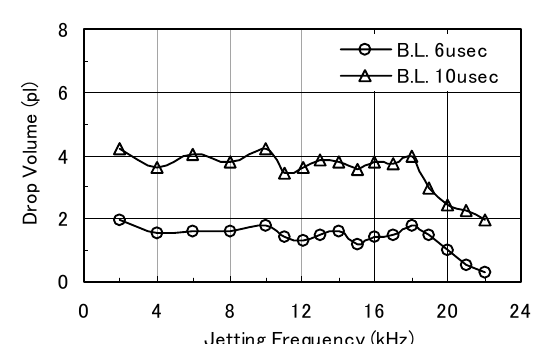
Fig.20 Dependency on Jetting